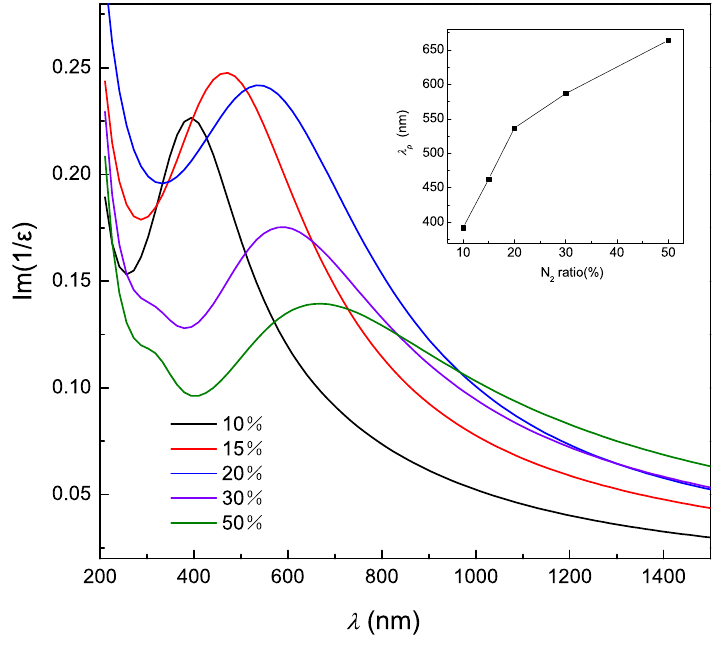
Figure 4. Energy loss spectra of the (Ti, Zr)N x films deposited with different nitrogen flow ratio. The inset shows the wavelength corresponding to the maximum of the energy